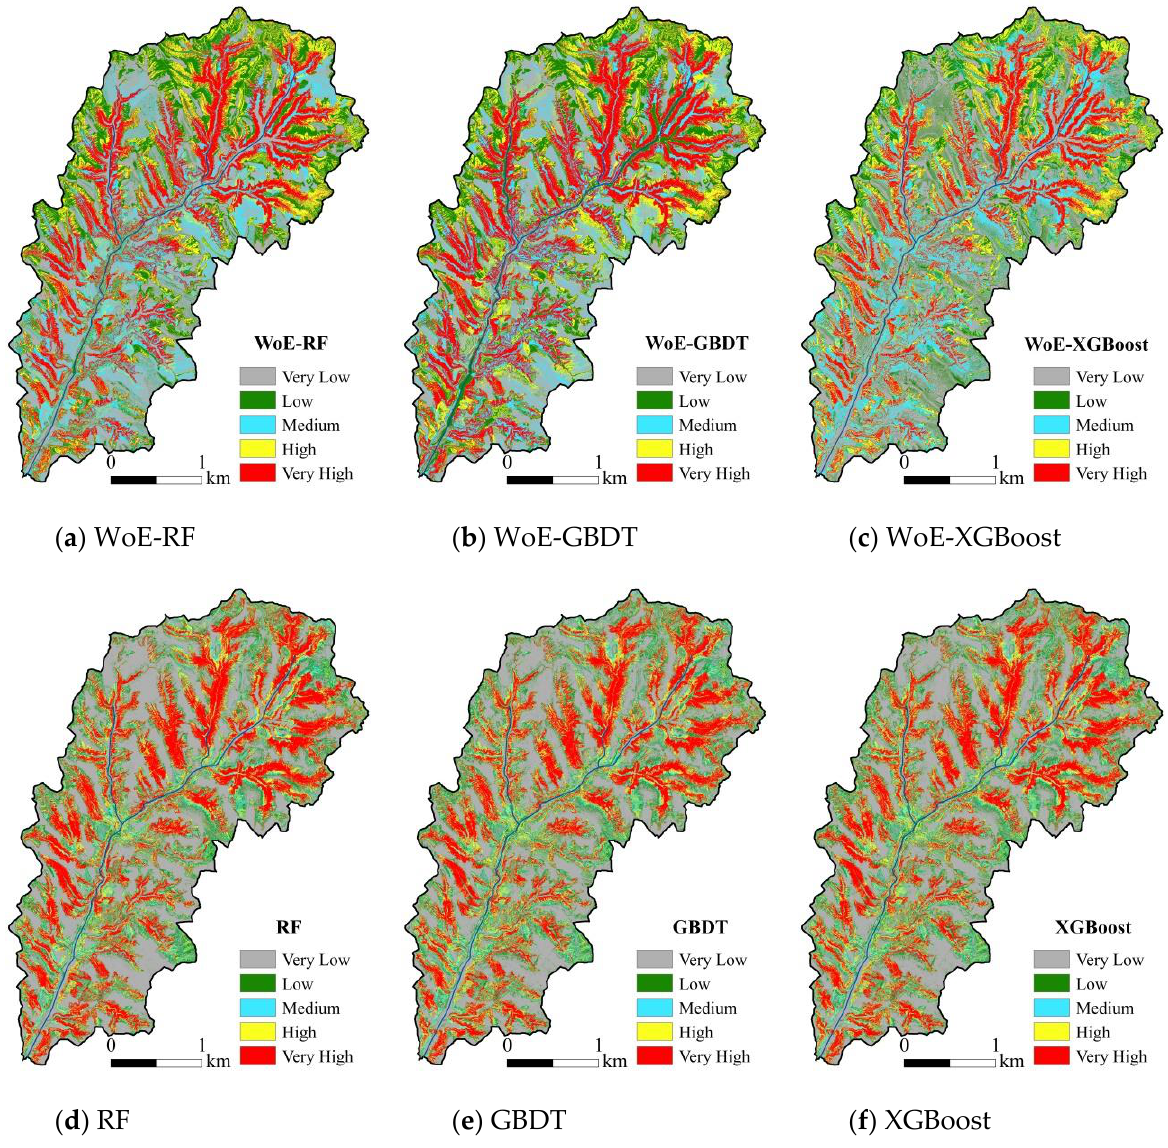
Figure 6. Gully erosion susceptibility maps by different models: ( a ) WoE-RF, ( b ) WoE-GBDT, ( c ) WoE-XGBoost, ( d ) RF, ( e ) GBDT, and ( f ) XGBoost.